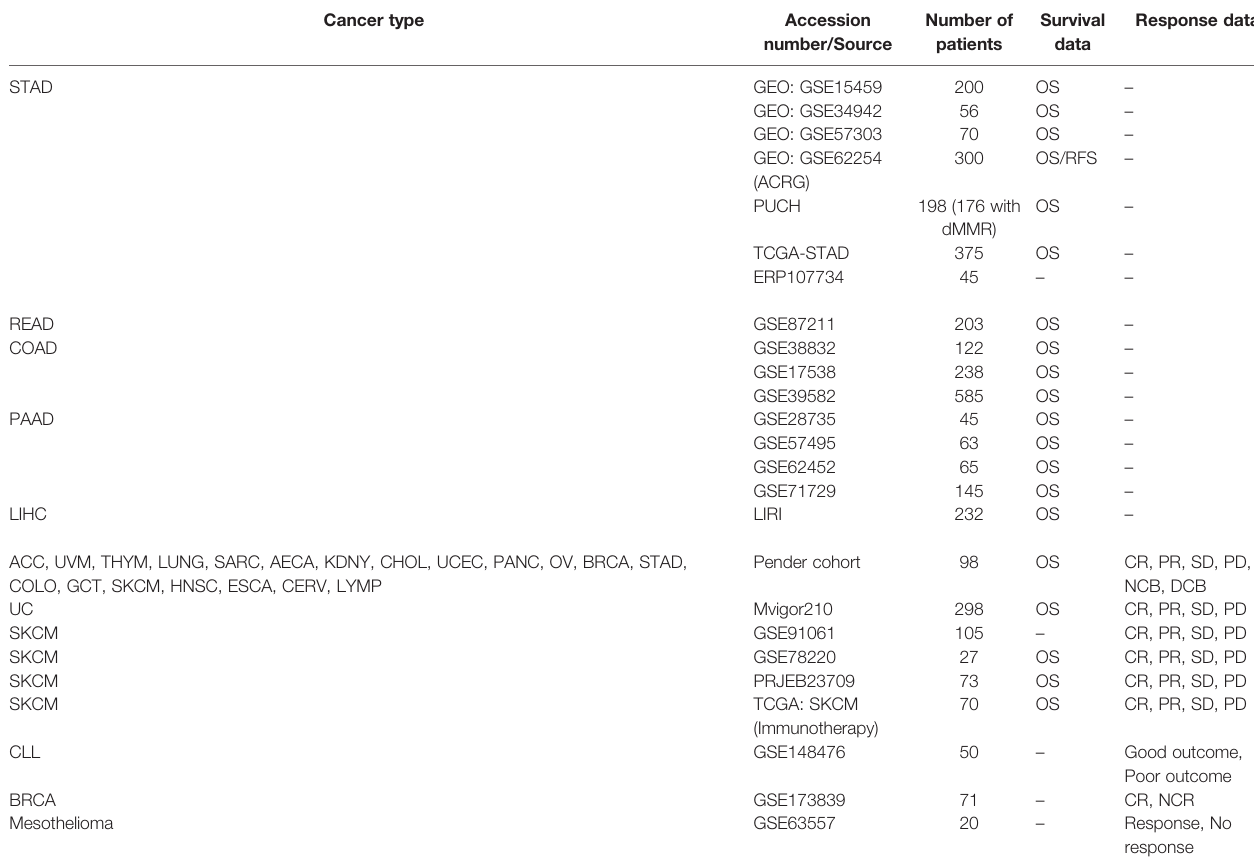
TABLE 2 | Basic information of datasets included in this